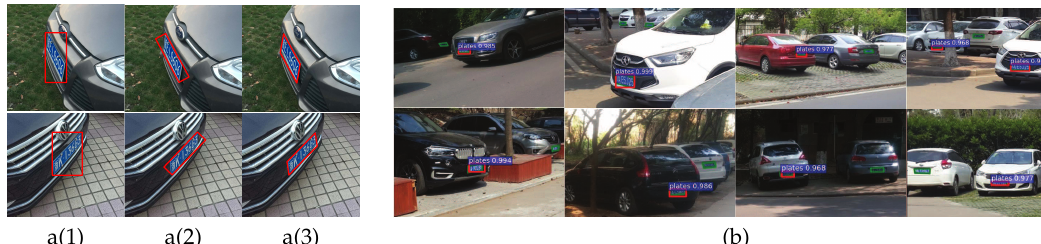
Figure 1. Two main challenges for existing methods. ( a ) Comparison between different bounding methods (horizontal rectangles, rotated rectangles, and our bounding parallelograms). Existing methods based on horizontal or rotated rectangles cannot tightly enclose the multi-oriented license plates. ( b ) Representative detection results of Faster R-CNN [27] trained for LPD. The detected regions and actual license plates are presented by red horizontal rectangles and green polygons, respectively. It is difficult to detect license plates with multiple scales, especially the tiny